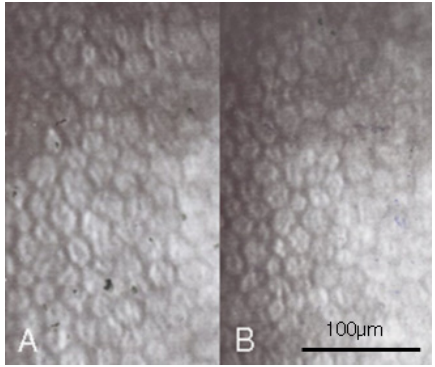
Figure 1. The initial endothelial cell morphology one year preoperatively with nominal magnification of 400×. ( A ) The endothelial morphology of right eye. ( B ) The endothelial morphology of left eye.